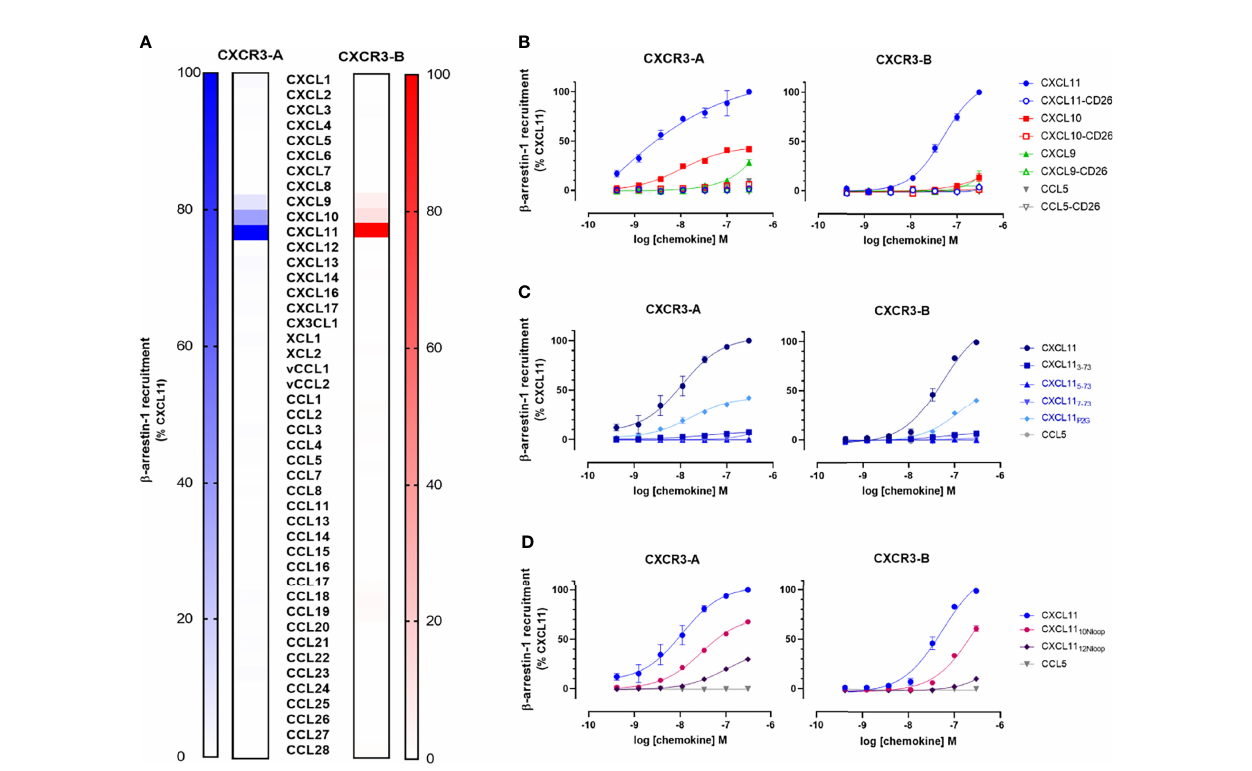
FIGURE 5 | N-terminal extension of CXCR3-B does not change the receptor selectivity and chemokine binding mode. (A) b -arrestin-1 recruitment to CXCR3-A (blue color scale) and CXCR3-B (red color scale) in response to all known human and two viral chemokines (100 nM). (B) Impact of chemokine N-terminal processing by dipeptidyl peptidase 4 (DPP4/CD26) on the chemokine-induced b -arrestin-1 recruitment to CXCR3 isoforms. (C) Impact of N-terminal truncation and P2G-mutation on CXCL11-induced b -arrestin-1 recruitment to CXCR3-A and CXCR3-B. (D) Recruitment of b -arrestin-1 to CXCR3-A and CXCR3-B in response to CXCL11 Nloop chimeras. All data were generated using NanoBiT-based assays in HEK293T cells and are expressed as percentage relative to maximum of the full agonist CXCL11 at 100 nM (A) or 300 nM (B – D) . Data represent mean ± SEM of three independent